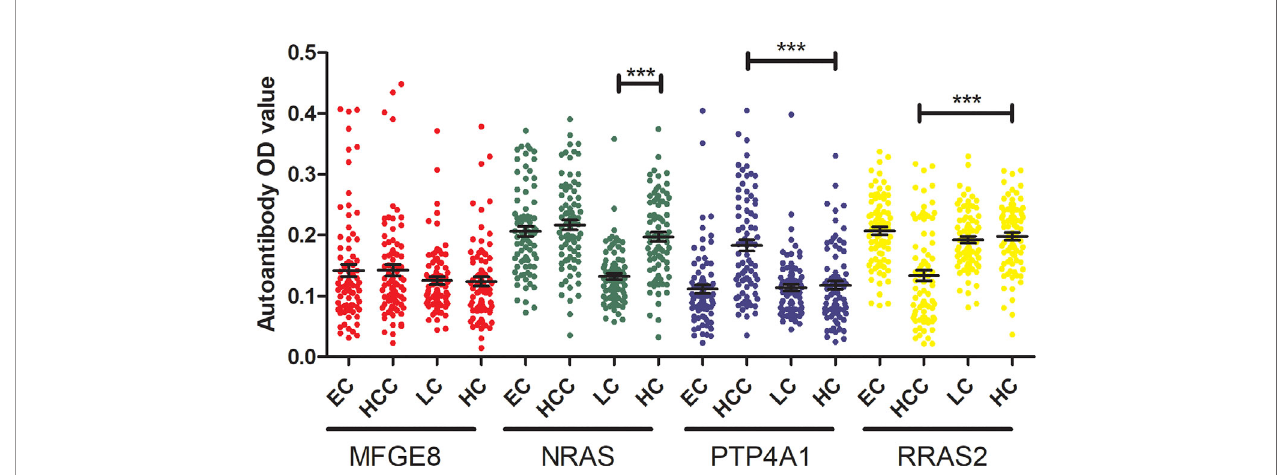
FIGURE 6 | The titer of four TAAbs in other types of cancer and HCs. (*** P <